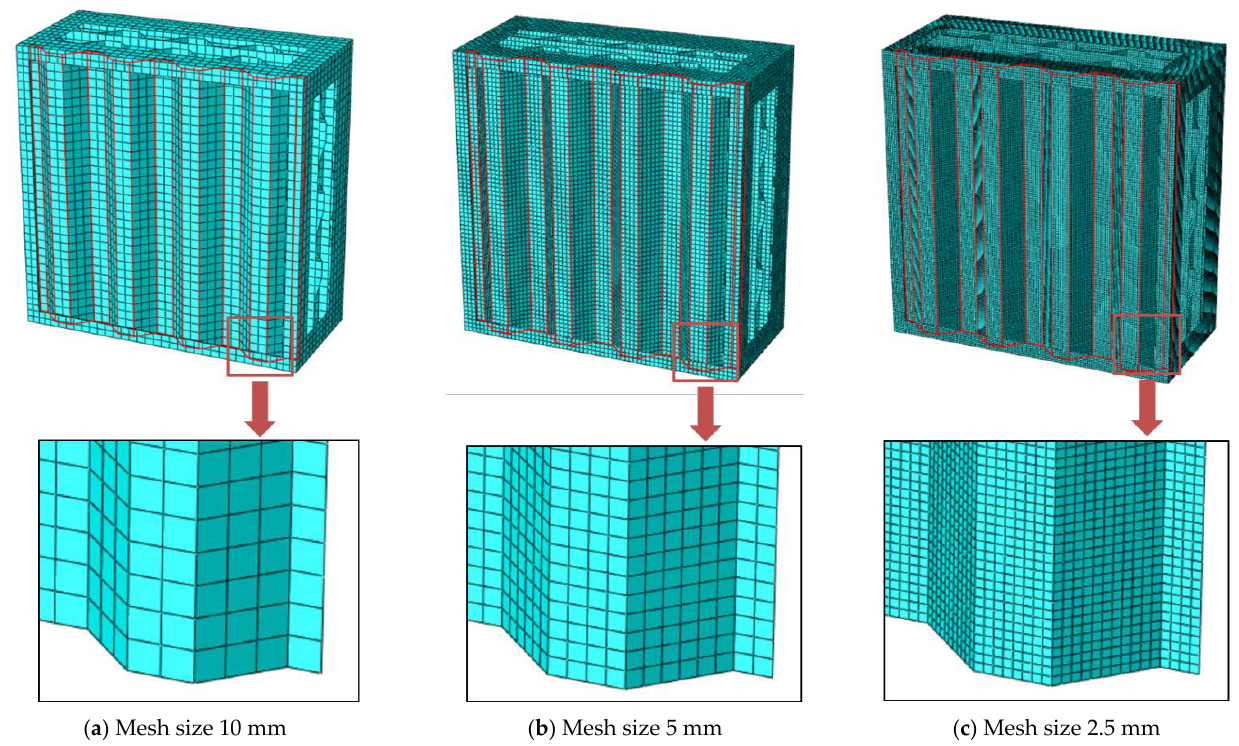
Figure 6. The trapezoidal sandwich panel with three different mesh/element sizes ( a ) 10 mm, ( b ) 5 mm, and ( c ) 2.5 mm.